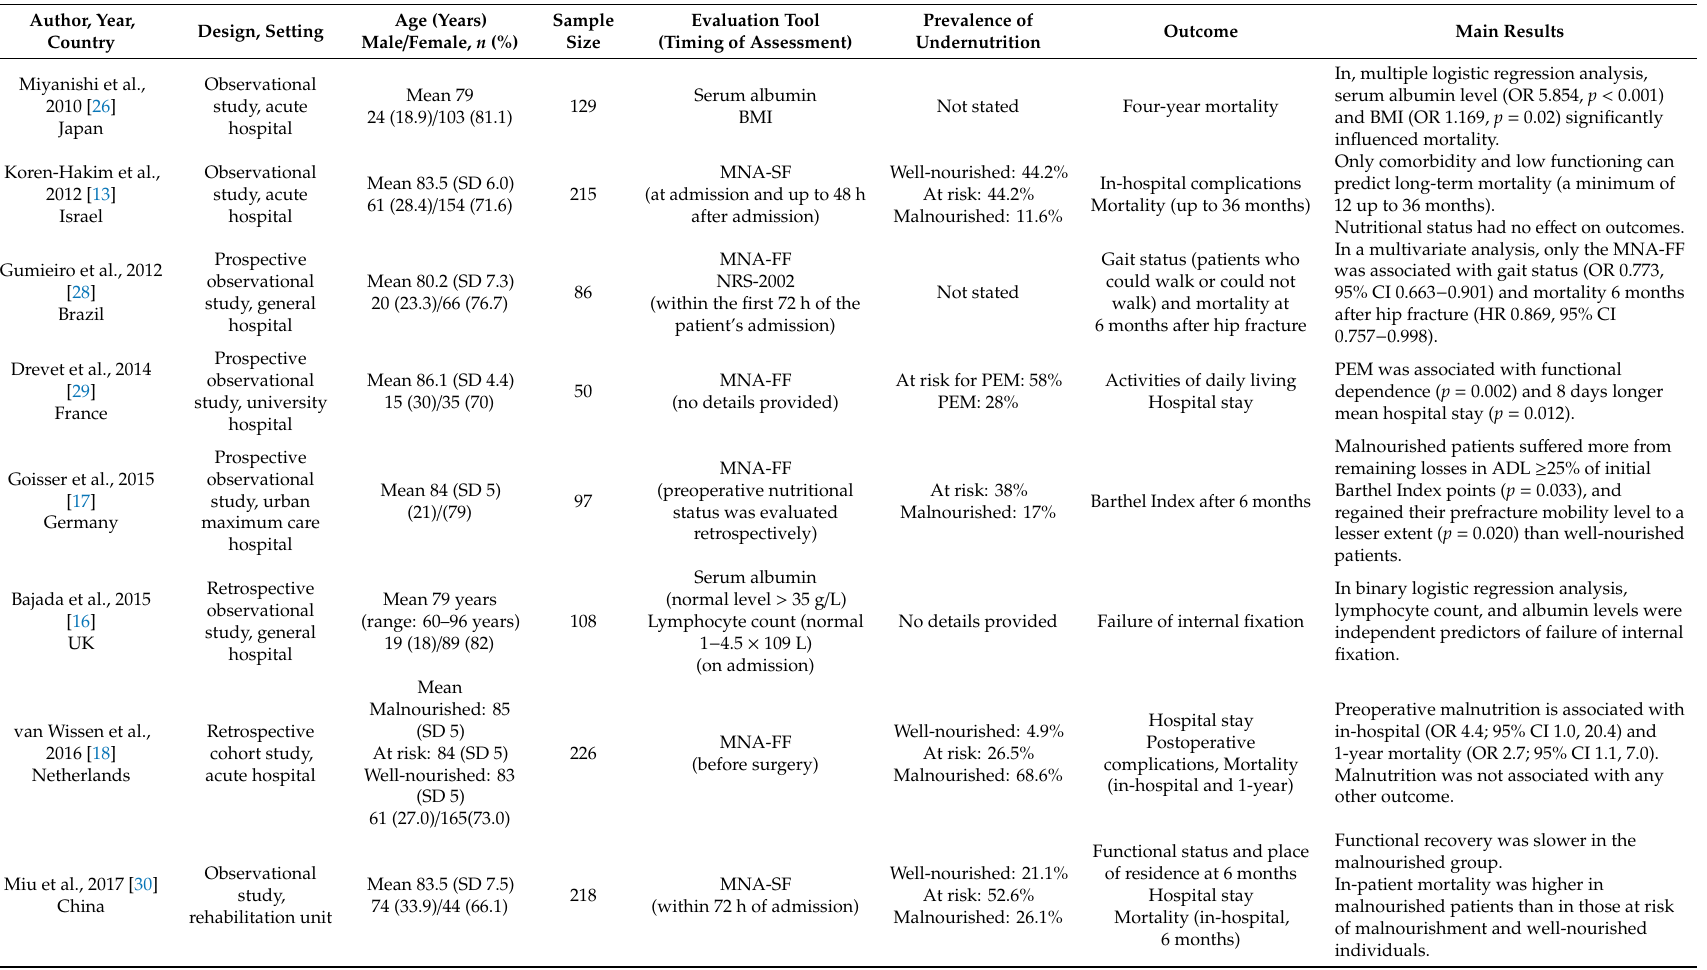
Table 1. Assessment of nutritional status, prevalence of undernutrition, and the impact of undernutrition on clinical outcomes in patients with hip